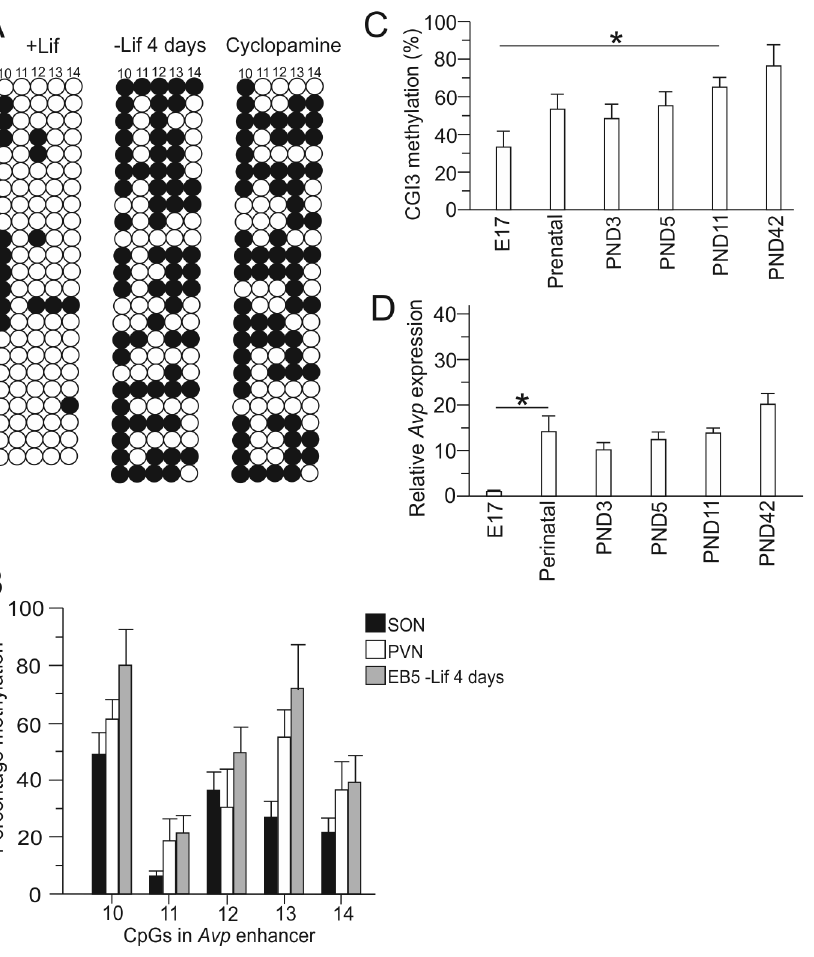
Figure 2. Hypothalamic-like differentiation triggered ELS-responsive DNA methylation at the Avp enhancer. A, ELS-responsive DNA methylation rapidly evolved following 4 days of Lif withdrawal and was maintained during subsequent cyclopamine treatment as evidenced by bisulfite sequencing of 25 clones. Shaded hemispheres represent percentage of methylation at each ELS-responsive CpG residue. Results are representative of three independent experiments. B, Comparison of ELS-responsive DNA methylation at the Avp enhancer in the SON, PVN and following hypothalamic-like differentiation of EB5 cells. C, Overall CpG methylation at CpG island 3 (CGI3) comprising the ELS-responsive Avp enhancer in the developing mouse hypothalamus. Postnatal days (PND) are indicated. D, Avp mRNA expression as evidenced by qRT-PCR analysis in the developing mouse dorsal hypothalamus. Bars represent standard deviations from the mean (sem), from 4–5 independent experiments.